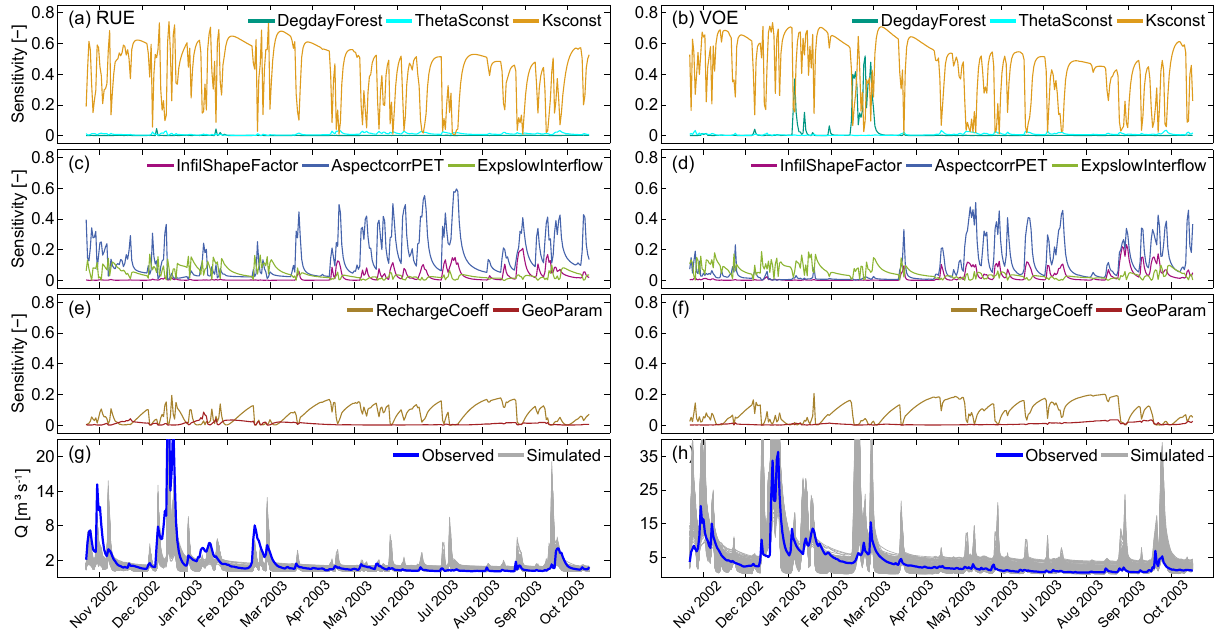
Figure 3. Time-dependent FAST sensitivities (TEDPAS) of eight global mHM parameters for two headwater gauges RUE (a, c, e) and VOE (b, d, f) , and observed and FAST-mHM simulated streamflow ensembles at gauges RUE (g) and VOE (h) . The results are shown for the hydrological year 2003 consisting of a wet season (November 2002–March 2003) and a long dry period from April 2003 to September 2003. Please note the different axis scaling for streamflow for the two headwaters (g, h)